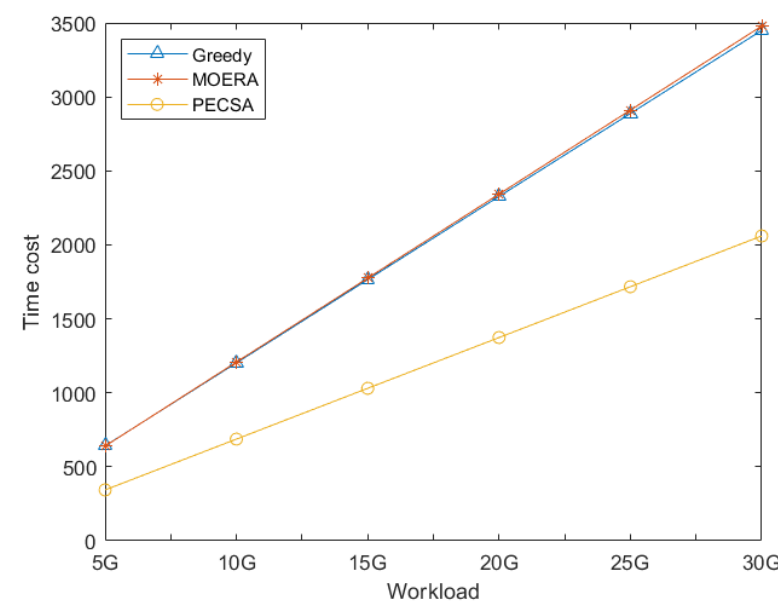
Figure 10. Service price